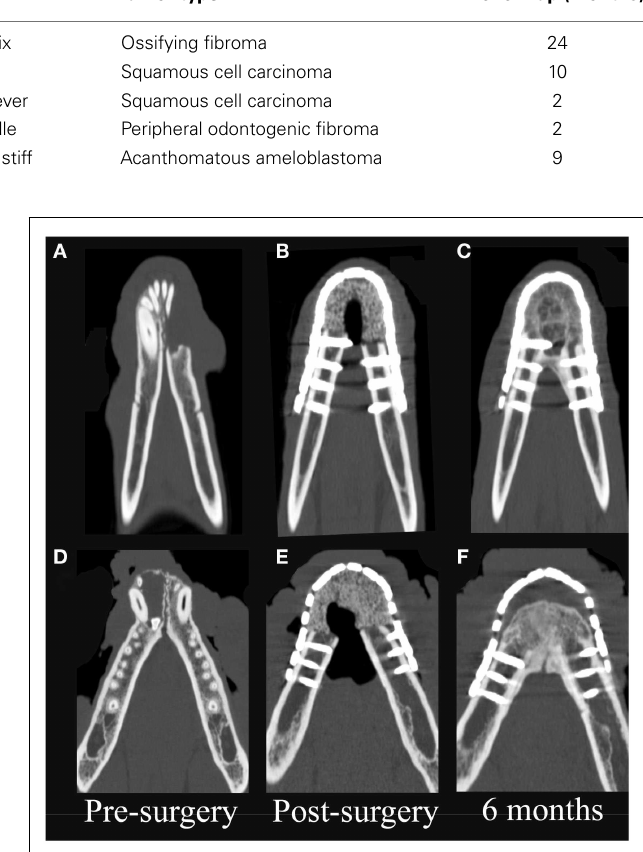
FIGURE 4 | Dorsal-plane, reconstructed, CT images of the mandibles in two patients prior to surgery (A,D), immediately postoperatively (B,E), and 6months after surgery (C,F) .The right side of the patient is displayed at the left side of each image. Note geographic osteolysis of the rostral left mandibles in patient 1 (A) and of the rostral right mandibles in patient 2 (D) associated with squamous cell carcinoma and acanthomatous ameloblastoma, respectively. After 6months, the borders between the scaffold and the native mandibles have become less distinct and new regenerated osseous tissue fills the rostral intermandibular